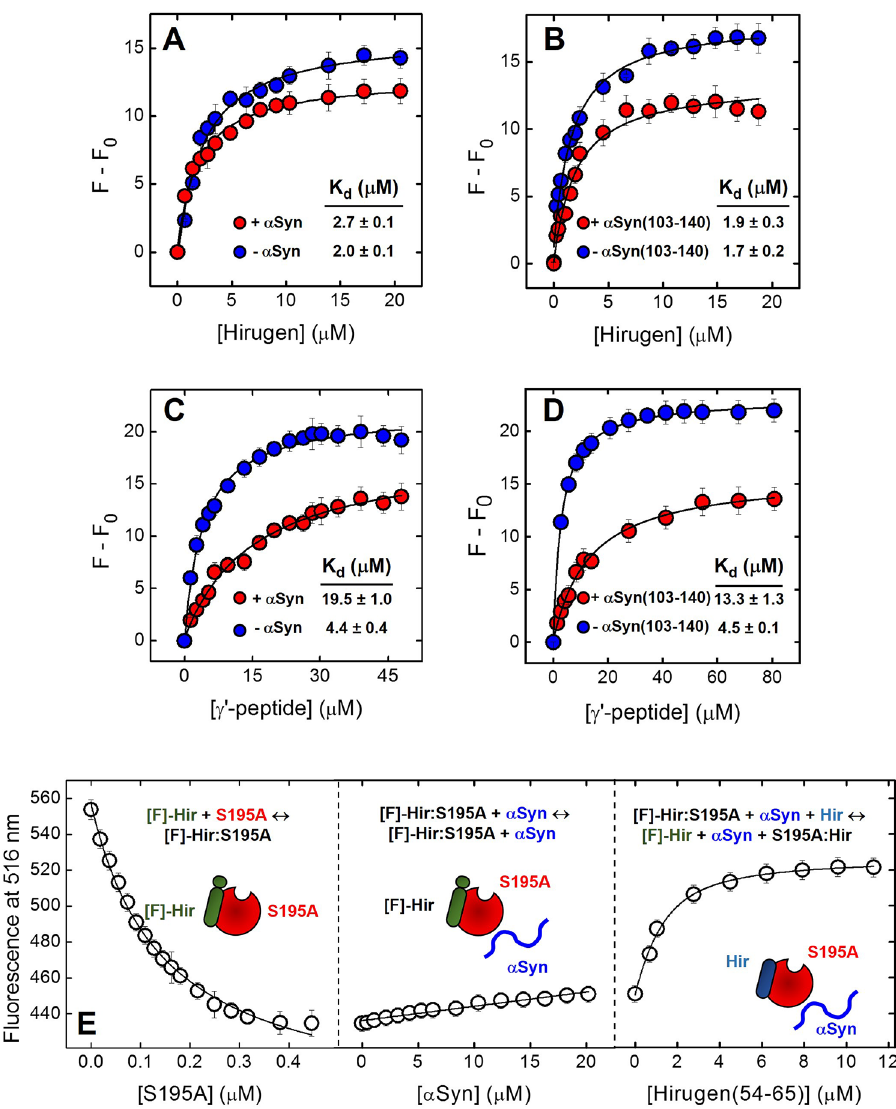
Figure 8. Probing the role of thrombin exosites in αSyn-αT interaction. ( A , B ) The role of exosite 1. Effect of αSyn and αSyn(103–140) on the affinity of hirugen for thrombin exosite-1. Fluorescence measurements of hirugen binding to αT (70 nM) in the absence or presence of saturating concentrations (20 μM) of full-length αSyn ( A ) or αSyn(103–140) ( B ). ( C , D ) The role of exosite 2. Effect of αSyn and αSyn(103–140) on the affinity of γ ′ -peptide for thrombin exosite-2. Fluorescence measurements of γ ′ -peptide binding to αT (70 nM) in the absence or presence of saturating concentrations (20 μM) of full-length αSyn ( C ) or αSyn(103–140) ( D ). Protein samples in HBS at 37 °C were excited at 295 nm and the fluorescence intensity was recorded at 334 nm, after baseline subtraction. The data points were interpolated with Eq. 5 (Supplementary Material) to obtain the K d values, as indicated. ( E ) Displacement of [F]-hirugen from αT exosite 1 by αSyn. Left panel, Binding of S195A to [F]-hirugen (60 nM). The data points were interpolated with Eq. 6 (Supplementary Material), yielding a K d of 30 ± 8 nM. Middle panel , Displacement of [F]-hirugen from the complex with S195A by incremental concentrations of αSyn. A moderate increase of fluorescence (~ 17%) was observed, suggestive of only a partial displacement of [F]-hirugen by αSyn. Right panel , Displacement of [F]-hirugen from S195A by incremental concentrations of unlabelled hirugen. A marked increase of fluorescence (~ 65%) was measured as the result of complete displacement of residual [F]-hirugen from αT exosite1. Samples in HBS, containing 0.1% PEG-8000, were excited at 25 °C at 492 nm and the fluorescence of [F]-hirugen, bound to or released from S195A, was recorded at 516 nm. All buffers contained 0.1% PEG-8000. The data points are the average of three independent measurements, with errors as ±